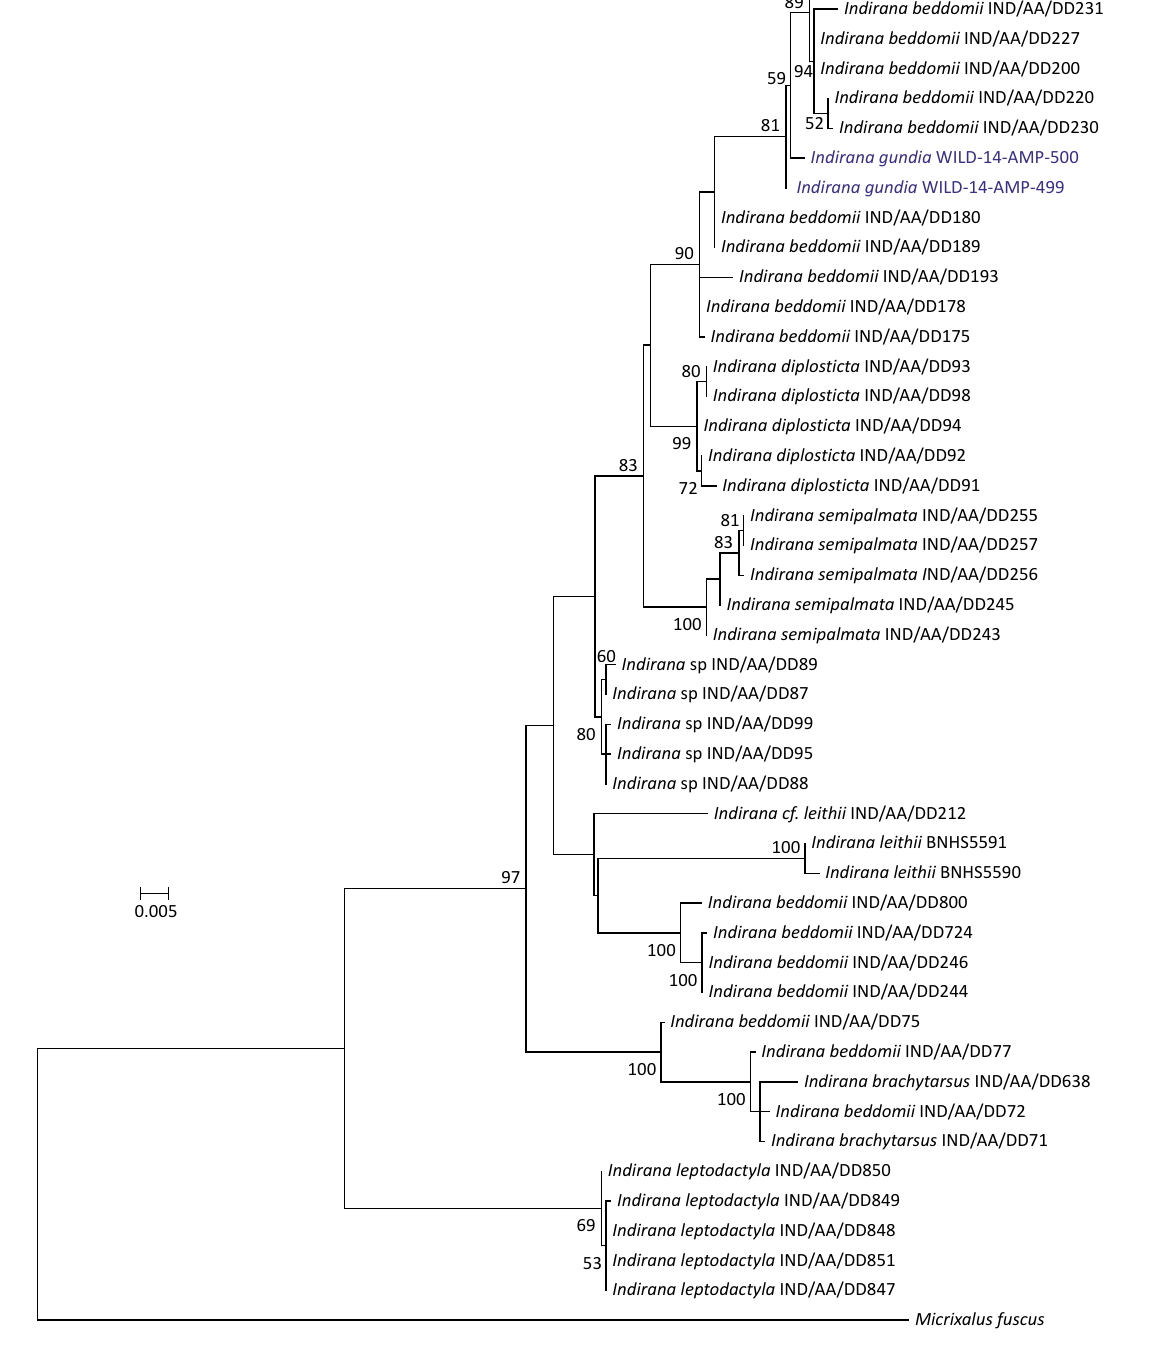
Figure 3. Maximum likelihood phylogenetic analysis of Indirana based on mitochondrial 12S and 16S genes and nuclear rho and rag1 genes. Best fit model for the nucleotide substitution was general time reversal model with gamma distribution and invariant sites (GTR+G+I, AIC = 10516.66, lnL = -5157.33, G = 0.385, I = 0.340). There were total 1342 bases in final matrix. Micrixalus fuscus is used as an outgroup. Numbers at the node are percent bootstrap values for 1000